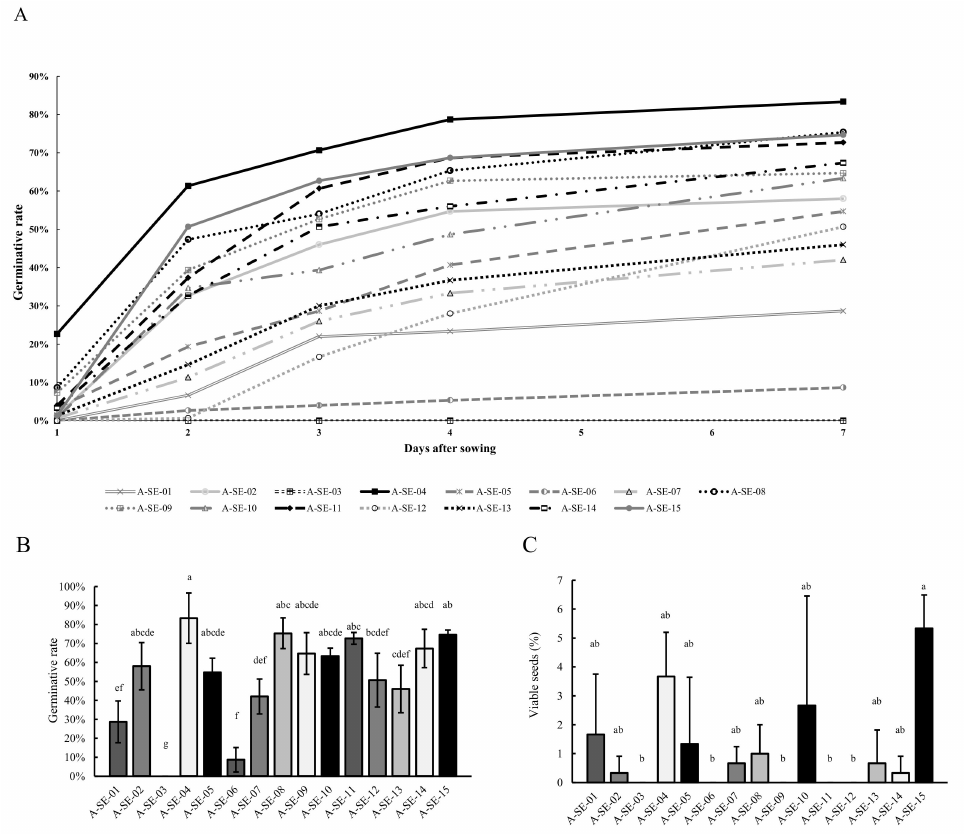
Figure 5. Germination rates (%) and seed viability. ( A ) Time course of the germination percentage (%) of quinoa seeds 1, 2, 3, 4, 5, 6, and 7 seven days after sowing (d.a.s.); ( B ) germination rate percentage (%) 7 d.a.s.; and ( C ) percentage (%) of viable seeds. Error bars represent the standard deviation. Bars that do not share the same letters show statistically significant differences following a Kruskal–Wallis test by ranks for multiple comparisons at a p -value <